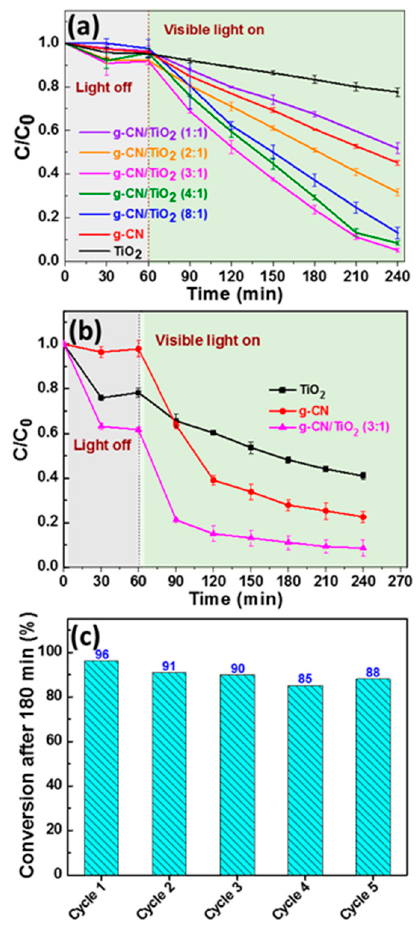
Figure 8. Photocatalytic degradation profiles of ( a ) Orange II and ( b ) tetracycline over TiO 2 , g-CN, and g-CN / TiO 2 catalysts under visible light irradiation, and ( c ) photodegradation stability of Orange II using the g-CN / TiO 2 (3:1) catalyst.